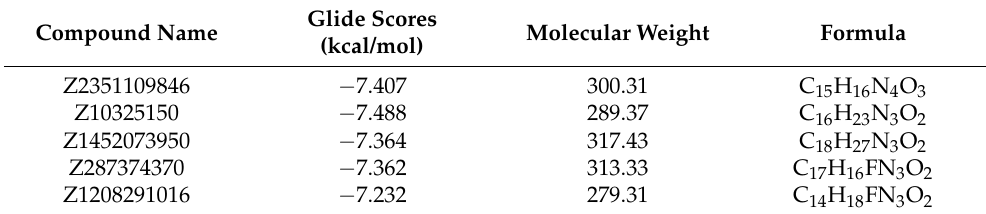
Figure 1. Molecular docking study and the structure of ligands for hepatitis A virus (HAV) 3C protease in the present study: ( A ) docking of Z10325150 in the active site of HAV 3C protease; ( B ) electrostatic potential of HAV 3C protease in complex with Z10325150; ( C , D ) 3D and 2D interac- tions between Z10325150 and HAV 3C protease; ( E ) structure of ligands for HAV 3C protein. Table 1. Ligands for hepatitis A virus 3C protease used in the present